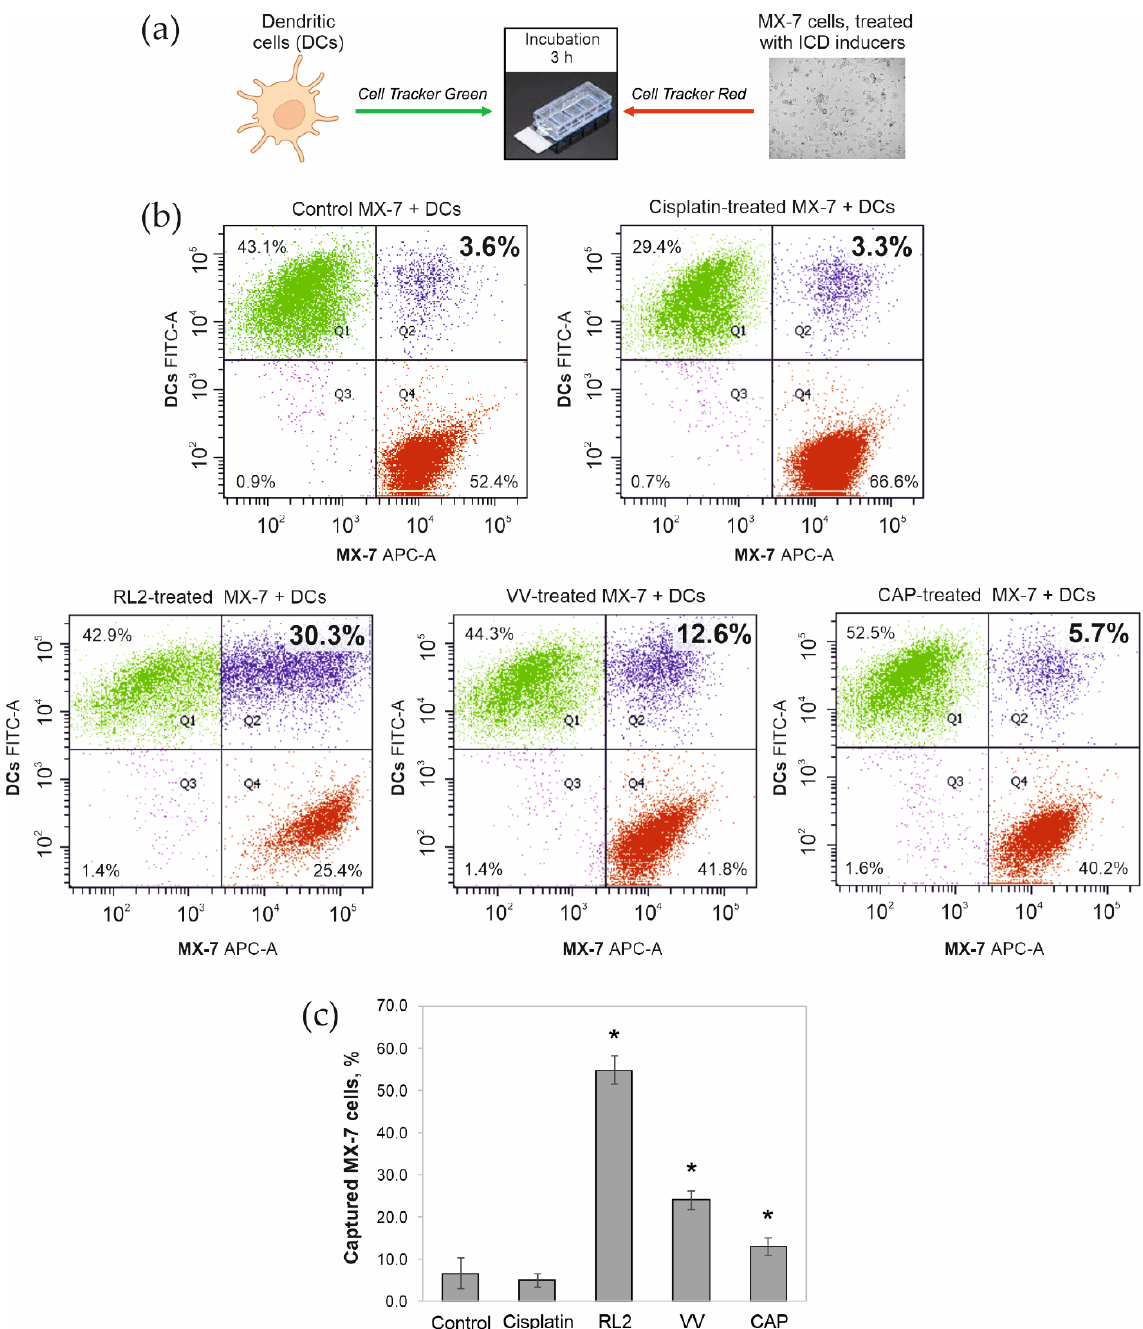
Figure 3. Phagocytosis of MX-7 cells by immature dendritic cells (DCs) from the red bone marrow of C3H/He mice. ( a ) Scheme of the experiment. MX-7 cells labeled with the Cell Tracker Red fluorescent dye (5 µM) were treated with RL2 (0.3 mg/mL, 24 h), VV-GMCSF-Lact (VV, 0.5 PFU/cell, 48 h), CAP (1 min, helium 9 L/min, 4.9 kV; 24 h after irradiation), or cisplatin (150 µM, 24 h). After treatment, the dying cells were incubated for 3 h with dendritic cells from the red bone marrow of C3H/He mice labeled with Cell Tracker Green (1 µM). ( b ) Representative images of the cytometric analysis. The quadrant Q2 contains a double-positive green/red population (phagocytosis). ( c ) Proportion of captured MX-7 cells. Statistical differences between control and experimental groups are indicated as * for p < 0.05.